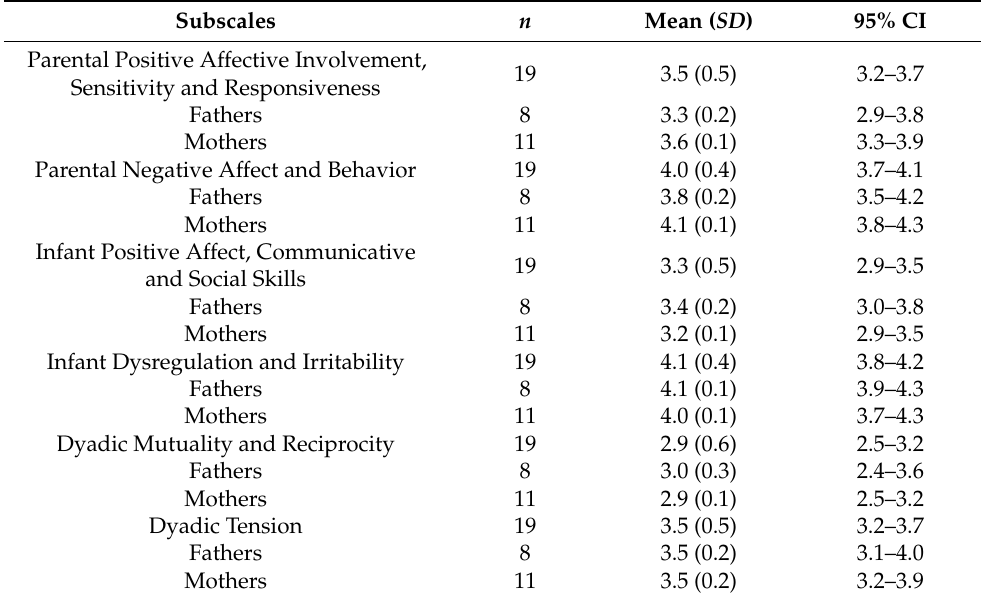
Table 4. The Parent–Child Early Relational Assessment subscales mean scores measuring the parent– infant interactions for the group and for mothers and fathers.